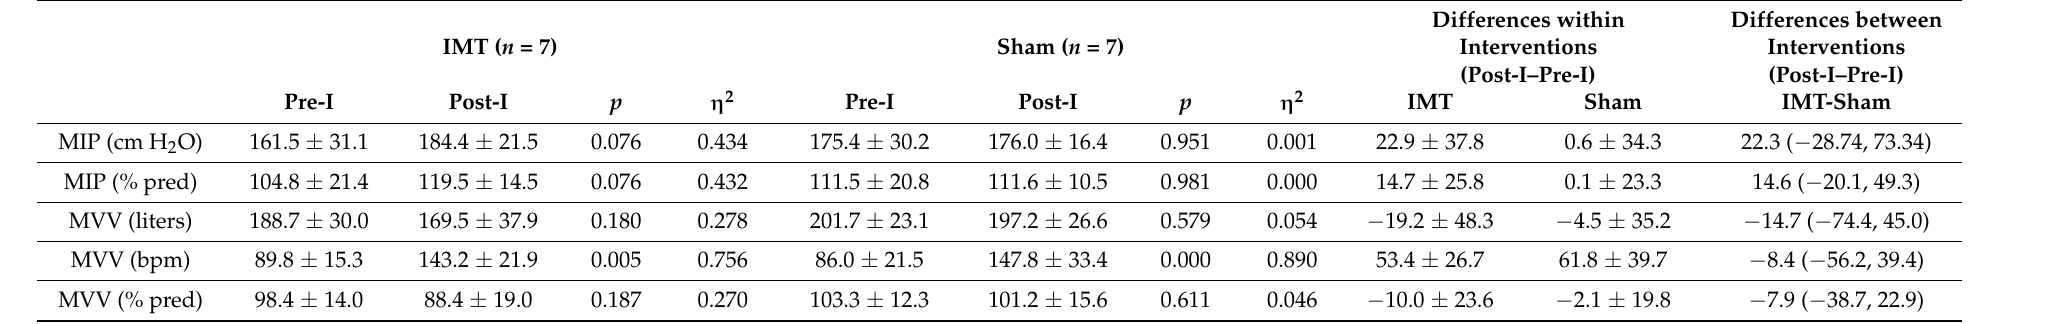
Table 3. Differences in respiratory function variables between groups